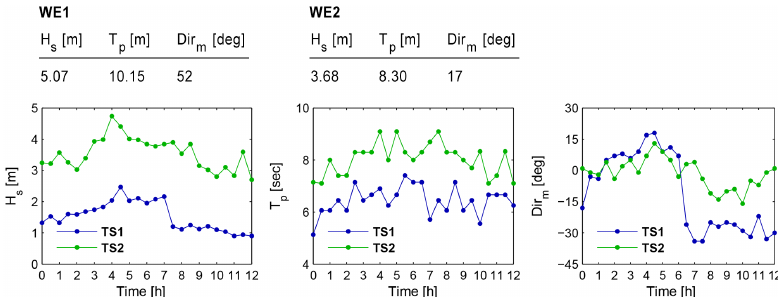
Figure 2. Characteristics of the wave events (WE1, WE2) and time series (TS1, TS2) used as forcings for TELEMAC and MIKE21 runs (see also Table